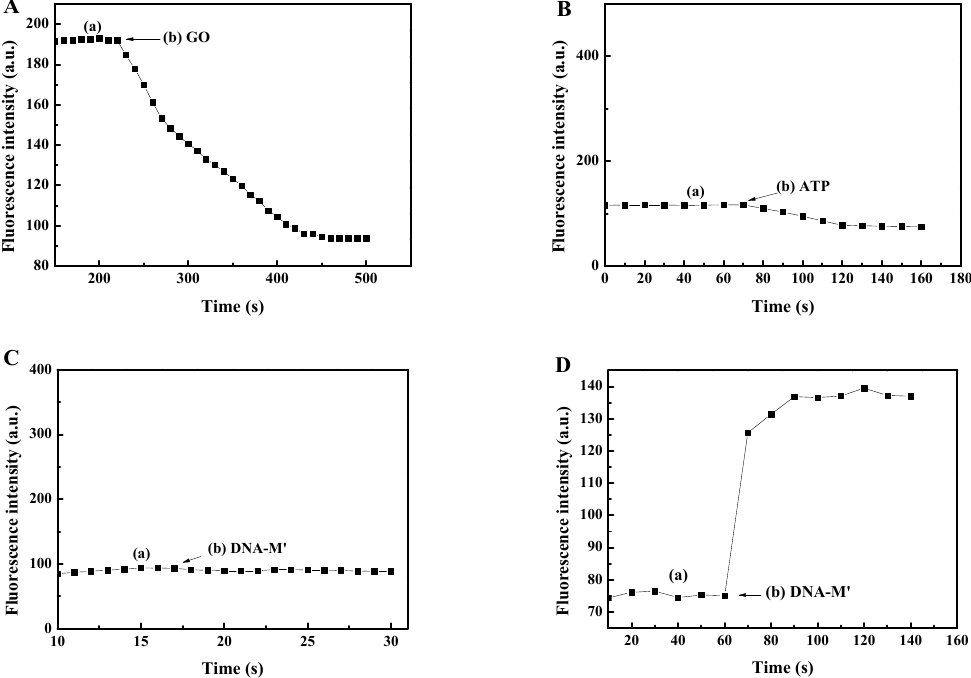
Figure 4. The investigation of the reaction time: ( A ) (a) DNA-T and DNA-M, (b) GO; ( B ) (a) DNA-T and DNA-M, (b) 200 µL of 10 µM ATP; ( C ) (a) DNA-T, DNA-M, and GO, (b) DNA-M ′ ; ( D ) (a) DNA-T, DNA-M, 200 µL of 10 µM ATP and GO, (b) DNA-M ′ .